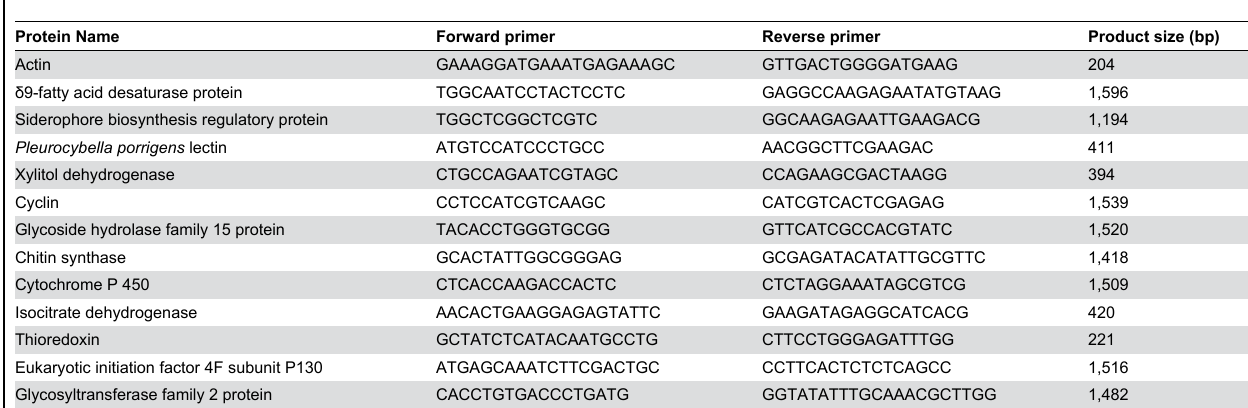
Table 4. Name of proteins, primers used and expected sizes of the RT-PCR products for semi-quantitative